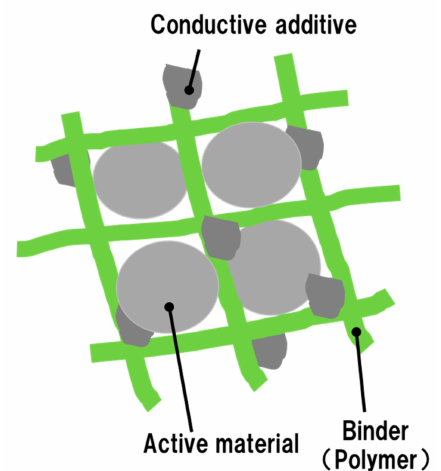
Figure 1. Ideal image of the anode composites with active materials, polymer, and conductive materials. Forourstudy, wechosesomeresins(binders)ofpolyvinylidenedifluoride(PVDF),polyamide-imide (PAI), polyimide (PI), thermoplastic polyimide (TPI), polybenzimidazole (PBI), polyacrylonitrile